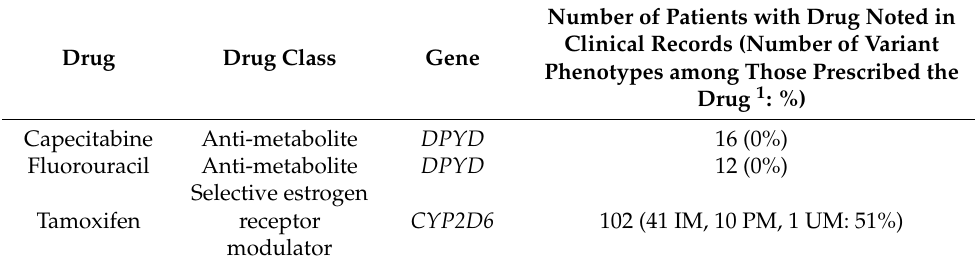
Table 1. Drug–gene (germline) pairs with relevance to the patients with breast cancer: anti-cancer